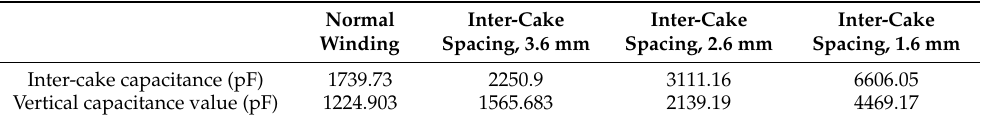
Table 9. Changes in circuit parameters.